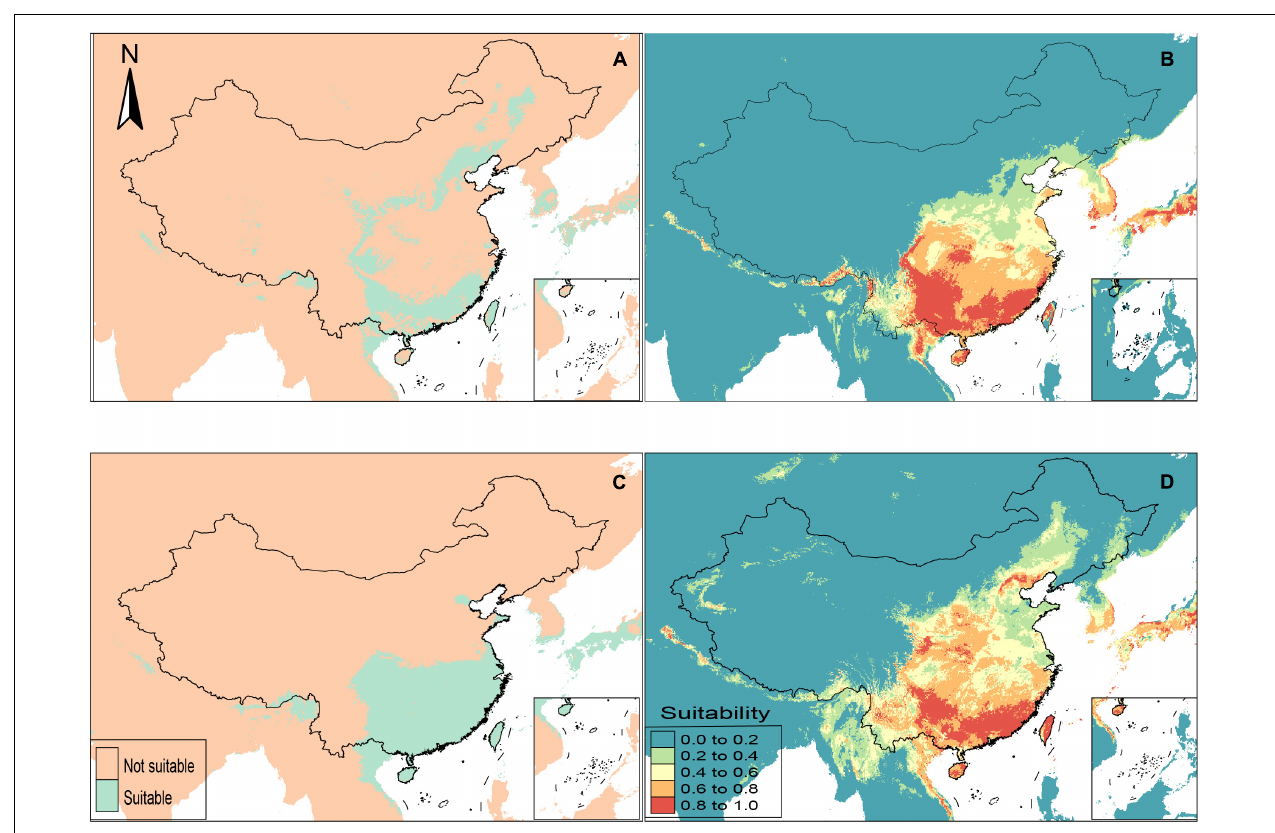
FIGURE 4 | Potential suitable distribution ranges of two slug moths ( N. flavidorsalis , A ; S. postornata , B ), and their host plants predicted using climate as predictive factors in MaxEnt. (A) Potential distribution ranges of N. flavidorsalis in China; (B) potential distribution ranges of Pyrus sorotina , which is the host plant of N. flavidorsalis ; (C) potential distribution ranges of S. postornata in China; (D) potential distribution ranges of three plants, Juglans regia, Populus simonii , and Camellia sinensis , which were selected as representative host plants of S.